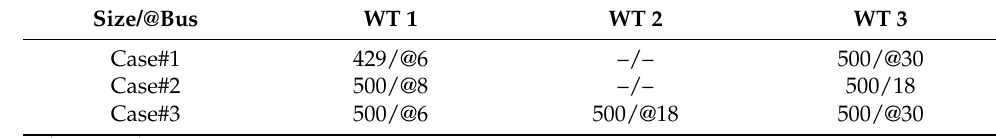
Table 2. Size and installation location of WTs in the 33-bus distribution network.